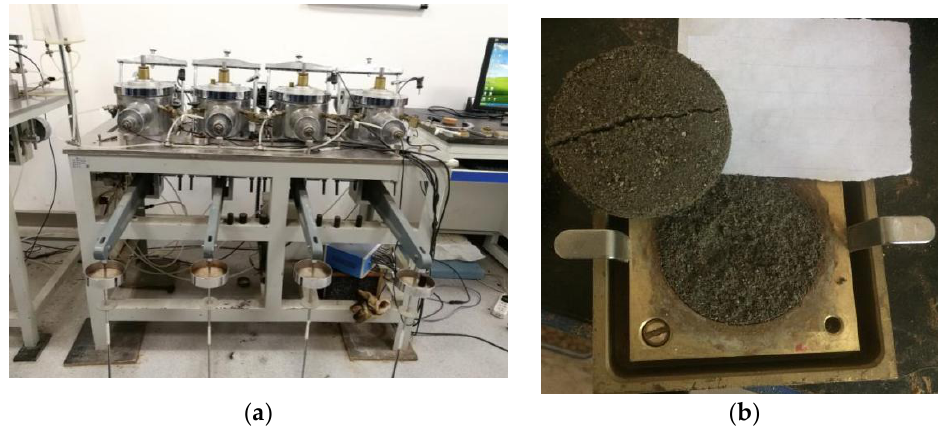
Figure 2. FDJ-20 soil direct shear instrument and the shear failure surface after shearing ( a ) Direct shear apparatus ; ( b ) S hear failure surface after shearing .